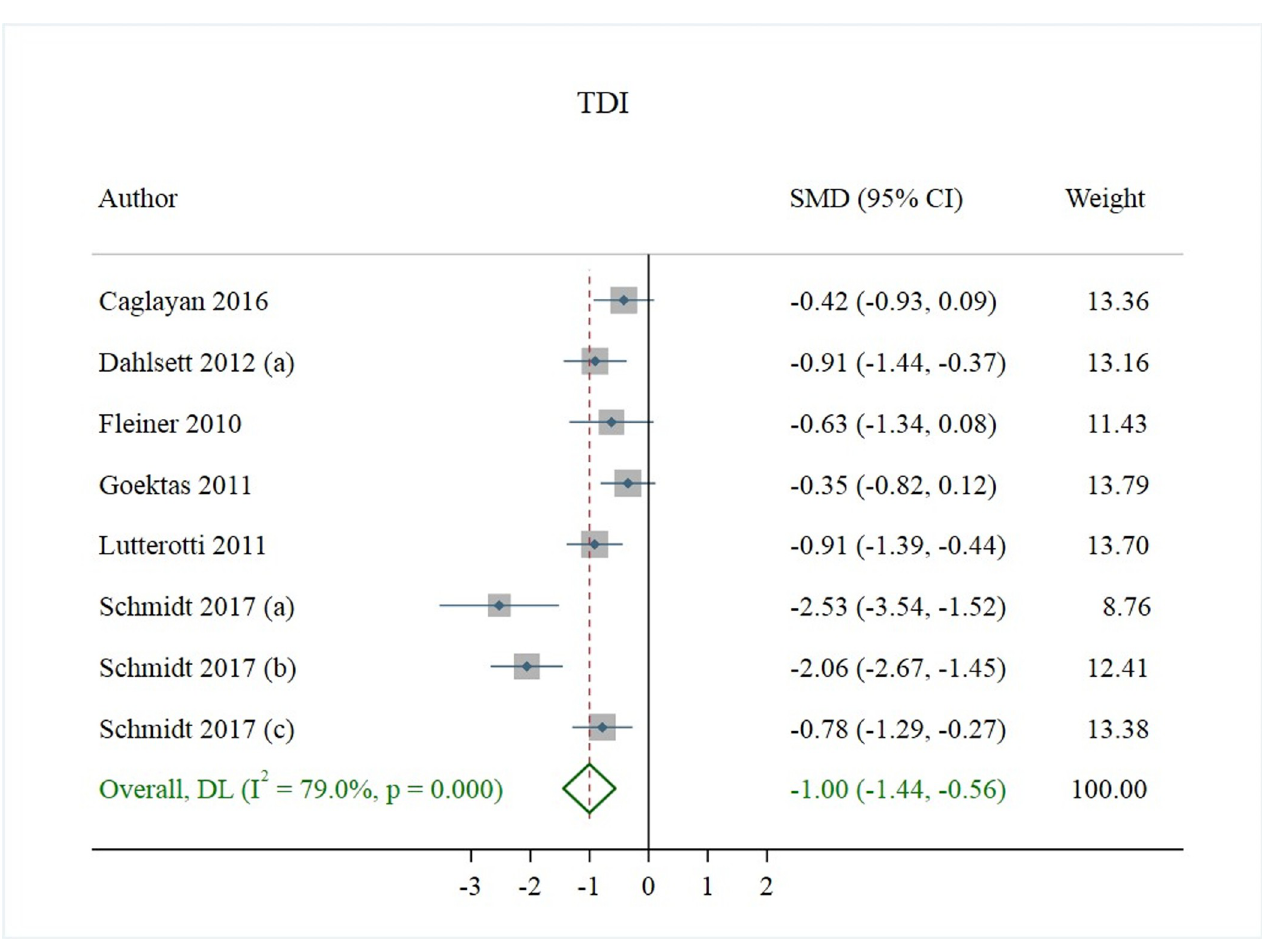
Fig 5. Studies reporting TDI, threshold, discrimination, and identification.